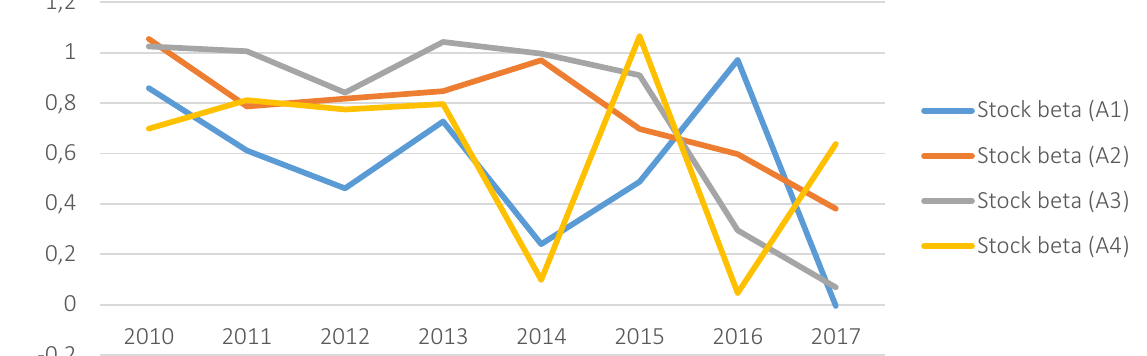
Figure 7. Comparison of mean of stock beta between A1, A2, A3, and A4